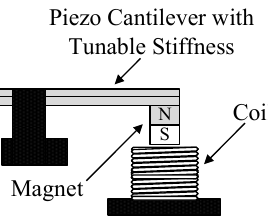
Figure 11. Schematic representation of the piezoelectric actuators based MTT proposed in [21,22].